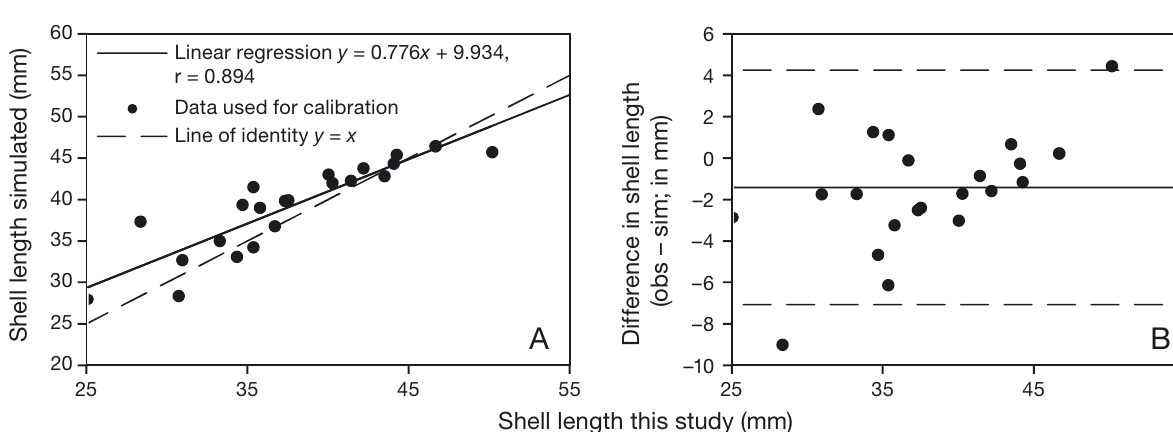
Fig. 6. (A) Shell length measured in this study versus simulated shell length for Manila clam; (B) transformed values from (A) where x -axis is the measured shell length and y -axis is the difference between the observed and simulated shell length. Horizontal line is the average difference while the dashed lines are ± 2 SD of this difference. NRMSD = 12.7% r 2 = 0.75